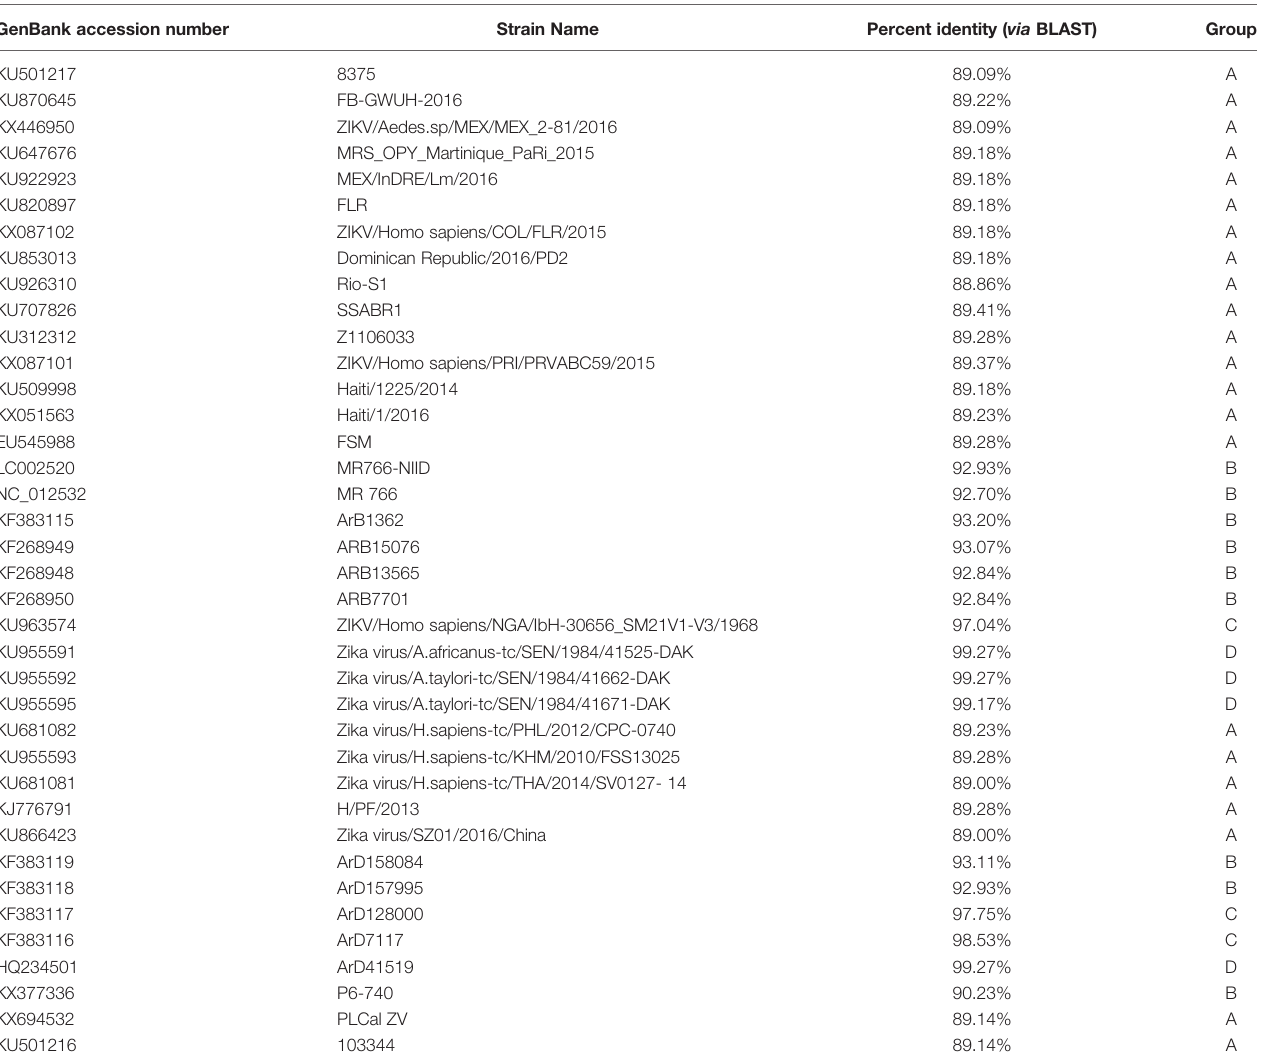
TABLE 1 | ZIKV strain list used to produce the phylogenetic tree. GenBank accession